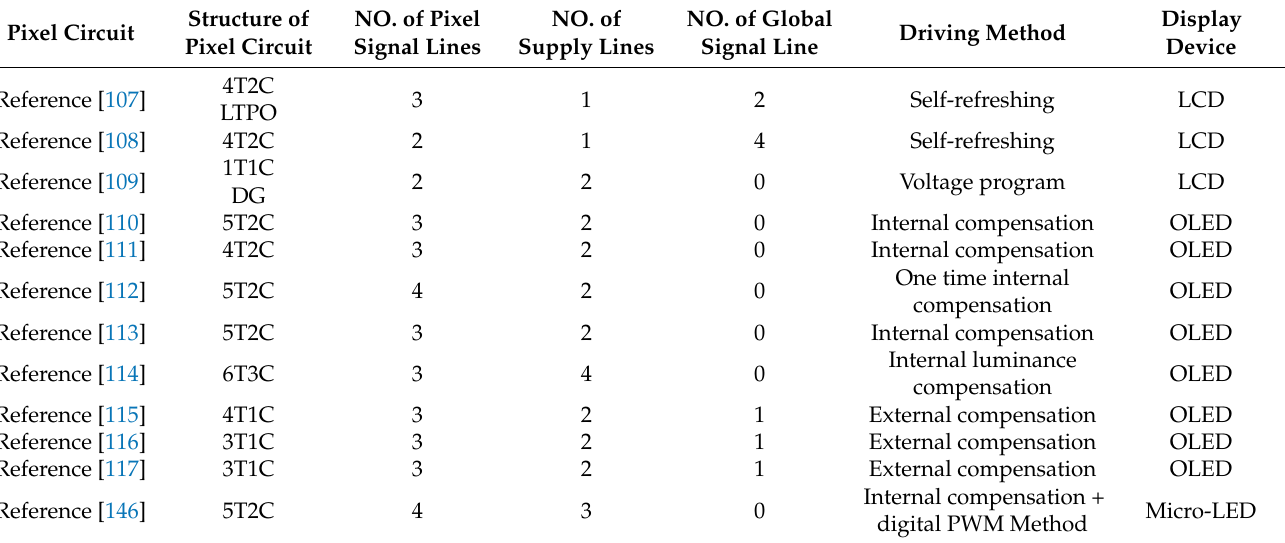
Table 1. Summarized performances for representative pixel circuits of oxide-based